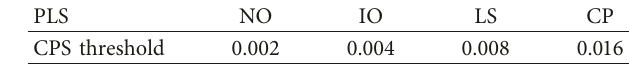
Table 4: CPS thresholds for different